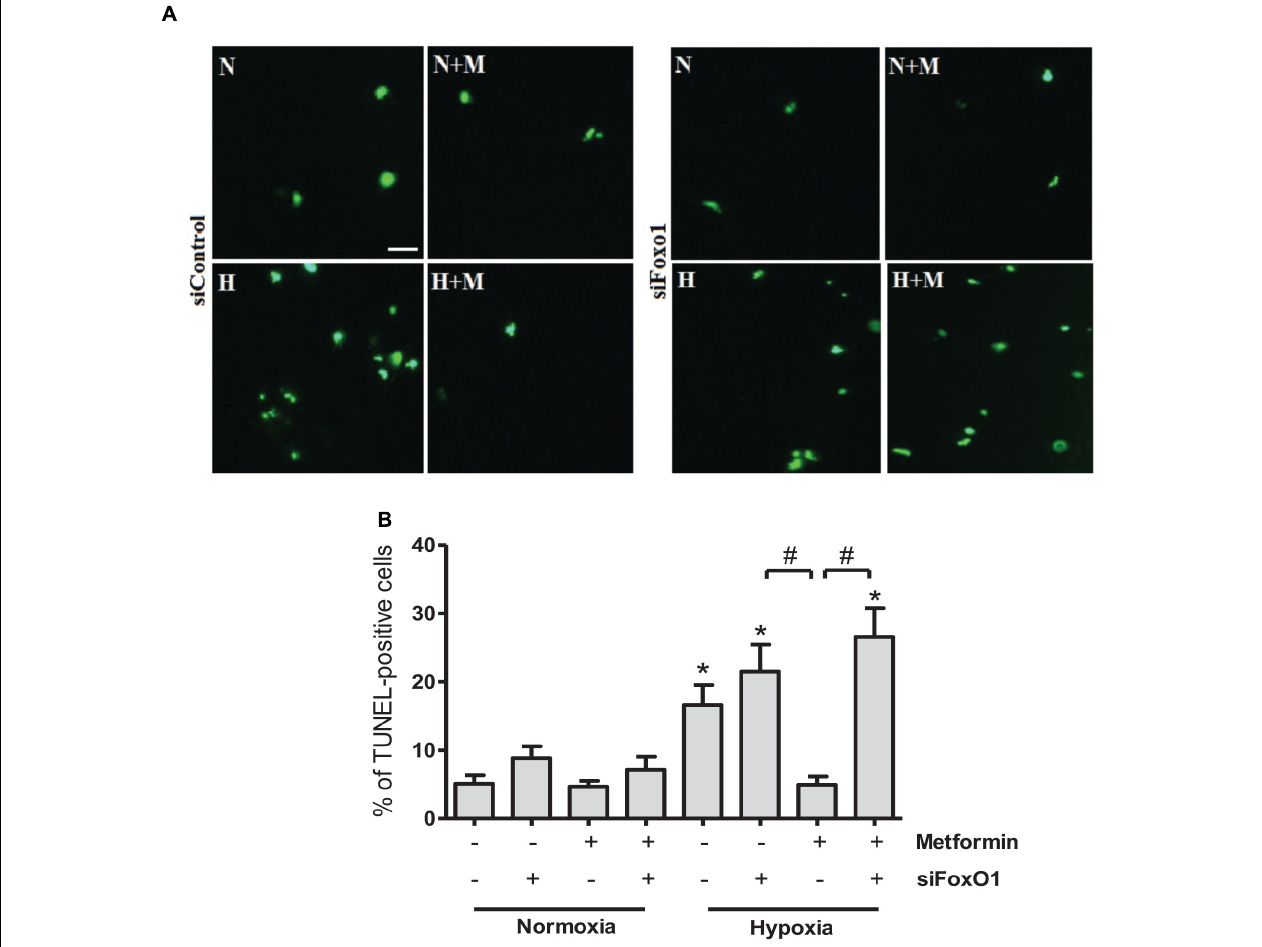
FIGURE 6 | Metformin prevents H9C2 cells from hypoxia-induced apoptosis through FoxO1 pathway. (A) Representative images of TUNEL staining of H9C2 cells transfected with control siRNA (siControl) or siRNA targeting FoxO1 (siFoxO1). Scale bar is 25 µ M. (B) Quantification of apoptotic cells from (A) . Data are presented as mean ± SEM. Statistical analysis was carried out by one-way ANOVA: ∗ P < 0.05 vs. control, # P < 0.05 between indicated